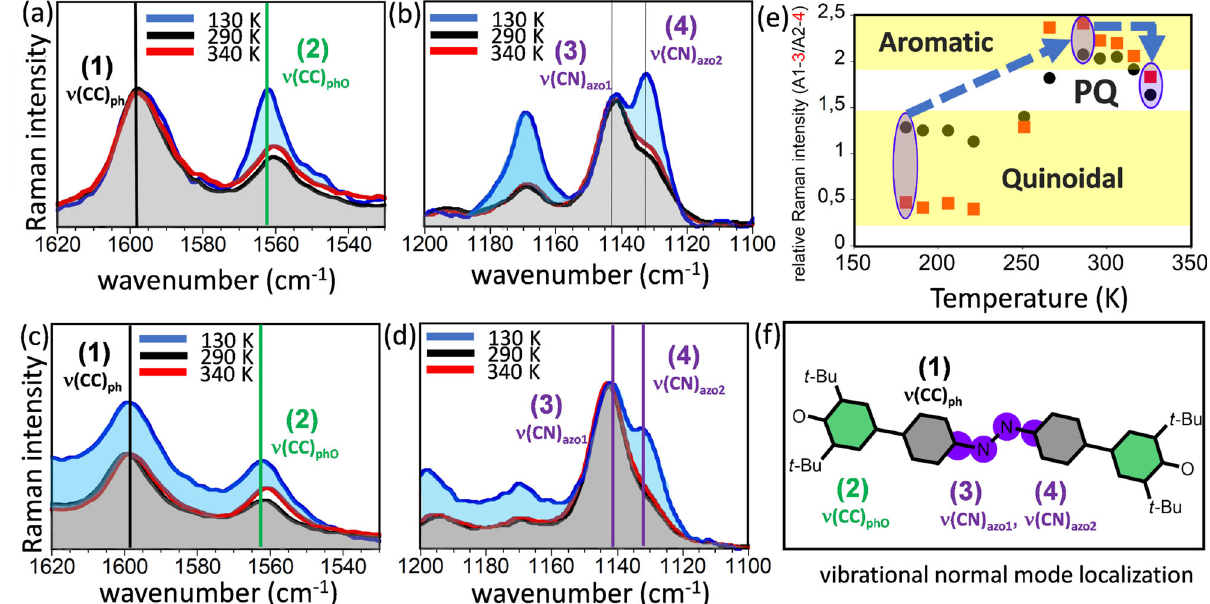
Fig. 4 Variable temperature vibrational Raman spectroscopy. Solid-state variable temperature Raman spectra of CAR taken with the 785 nm ( a ) and ( b ) and with 633 nm excitation wavelength ( c ) and ( d ) in two different vibrational intervals where the four important (strongest) bands are denoted as (1) ν (CC) ν (CC) ν (CN) ν (CN) ph ; (2) phO ; (3) azo1 ; and (4) azo2 . e Representation as a function of the temperature of the ratio of intensities of 1 (A1) and 2 (A2) as black circles and 3 (A3) and 4 (A4) bands as red squares as spectroscopic markers of the degree of quinoidal/aromatic character, which delineates three regions: small ratio means more quinoidal, large ratio more aromatic and pseudoquinoidal (PQ) is in between. f Topologies of the vibrational modes from the theoretical Raman spectra in Supplementary Figs. 12 – factors 28 alongside the two above structural transitions (Supple- corresponds to two separated processes. An (0.81 → 0.92) increase for Q → A followed by a (0.92 → 0.88) decrease for A → PQ, where mentary Table 10), which reveal that the set of vibrational normal the latter step cannot be viewed as a way back the evolution of the mode contributions that conduct the two transformations are former. This is deduced from calculations of the Huang-Rhys different (e.g., there is not a vibrational reaction coordinate that